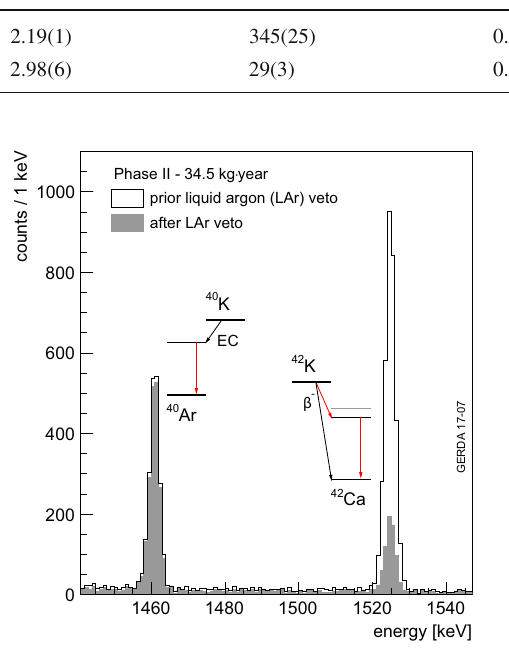
Fig. 28 Monitoring the LAr veto performance with the 40 K and 42 K γ lines (see text)